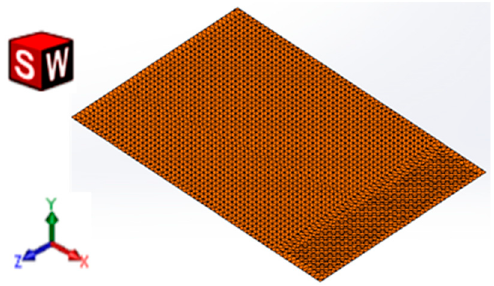
Figure 1. A 3D meshing model of a composite